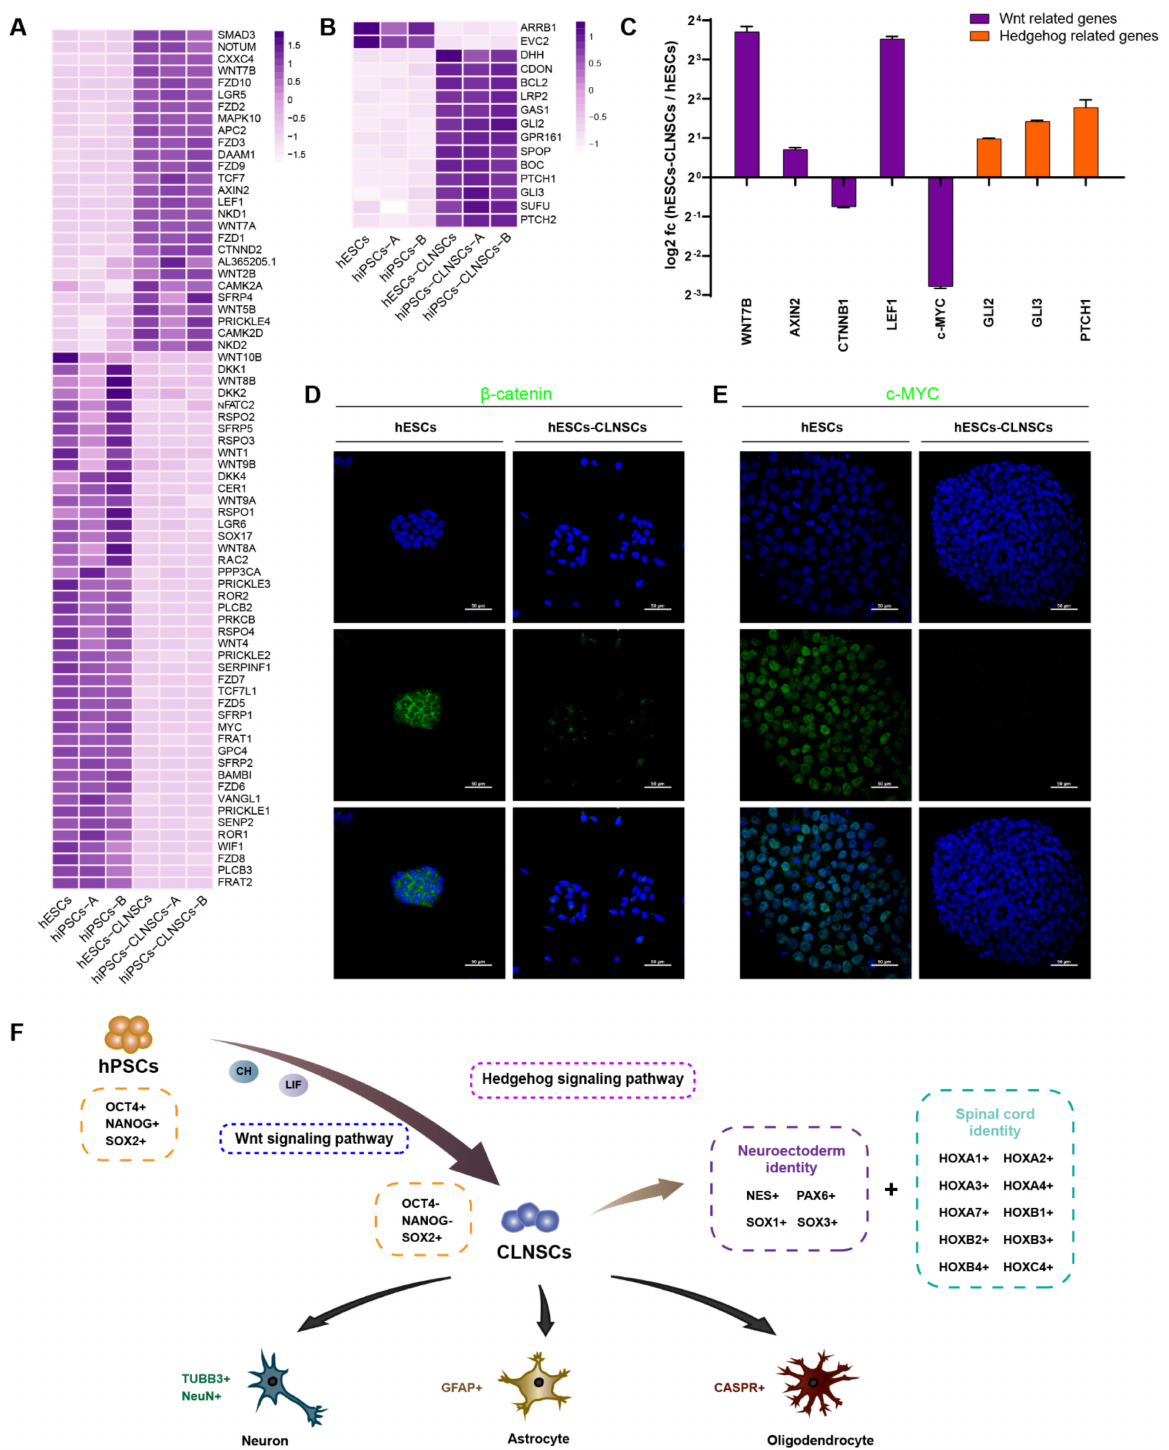
Figure 6. Gene expression patterns in the Wnt and Hedgehog signaling pathways. ( A ) DGEs (|log2 (fold change)| > 1, FDR < 0.05) related to Wnt signaling pathway are shown in the heatmap. ( B ) DGEs (|log2 (fold change)| > 1, FDR < 0.05) related to Hedgehog signaling pathway are shown in the heatmap. ( C ) Relative gene expression of Wnt and Hedgehog signaling pathways in the hESCs-derived CLNSCs compared to hESCs are presented in log2 (fold change). ( D ) Immunofluorescence staining for β -catenin in hESCs (Passage 28) and hESCs-CLNSCs (Passage 18), scale bar: 50 µ m. ( E ) Immunofluorescence staining for c-MYC in hESCs (Passage 28) and hESCs-CLNSCs (Passage 18), scale bar: 50 µ m. ( F ) Schematic diagram of the conversion process of CLNSCs induced from hPSCs by CHIR-99021 and LIF, and the spinal cord region- specific identities of these